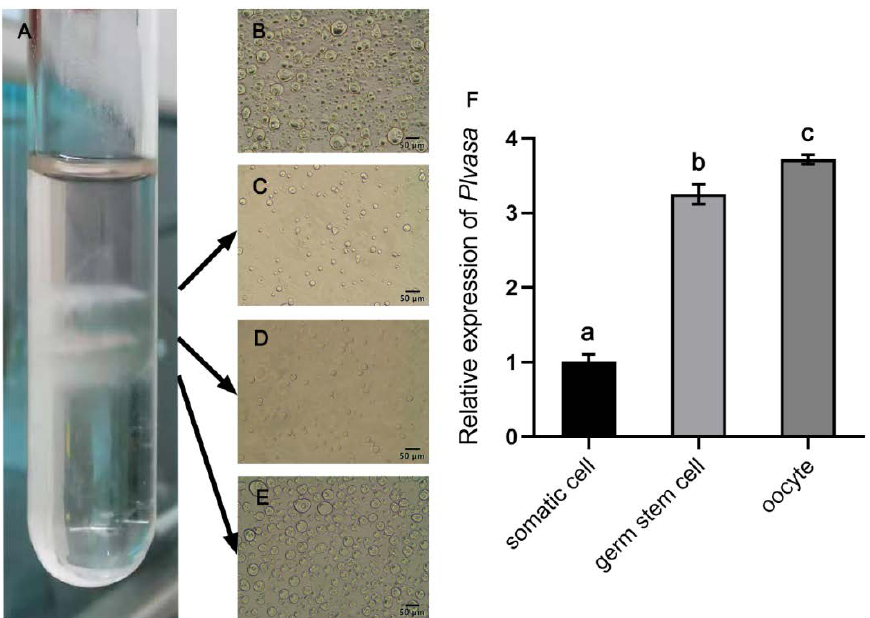
Figure 7. Purification enrichment of germ stem cells from 6-month-old leopard coral grouper ( Plectropomus leopardus ) by Percoll centrifugation and expression levels of plvasa . ( A ) Three layers in the tube after purification. The gradient-separated cells in three layers were observed and detected individually. ( B ) The results of cell dissociation before purification. ( C ) The cells present in the first layer contained a higher percentage of somatic cells. ( D ) Germ stem cells in the second layer. ( E ) The oocytes were at different stages in the third layer. ( F ) Expression levels of vasa in purified cells of three layers by q-PCR. The relative expression of each layer (somatic cells, germ stem cells and oocytes) was calculated by the 2 −ΔΔCt method. Data are shown as mean ± SD. Letters ( a, b and c) reveal statistical significance ( p < 0.05), which was calculated by one-way analysis of